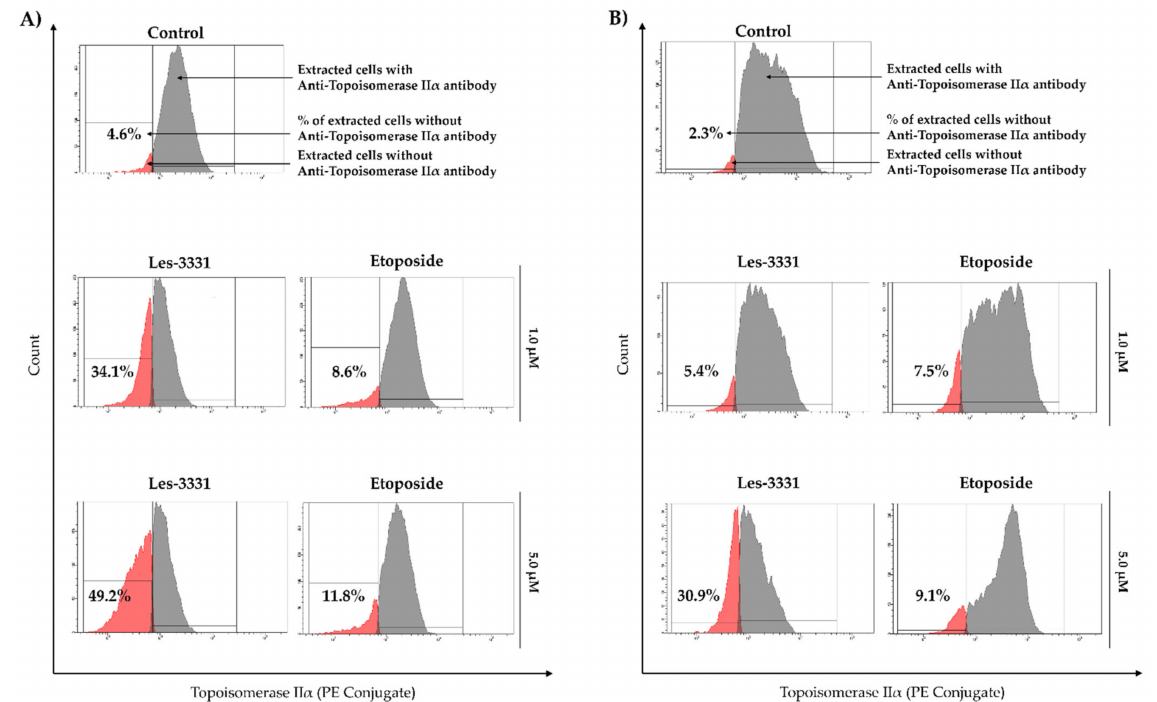
Figure 12. Anti-topoisomerase II α antibody analysis of MCF-7 ( A ) and MDA-MB-231 ( B ) human breast cancer cells after 24 h incubation with Les-3331 and reference drug (etoposide) at 1 µ M